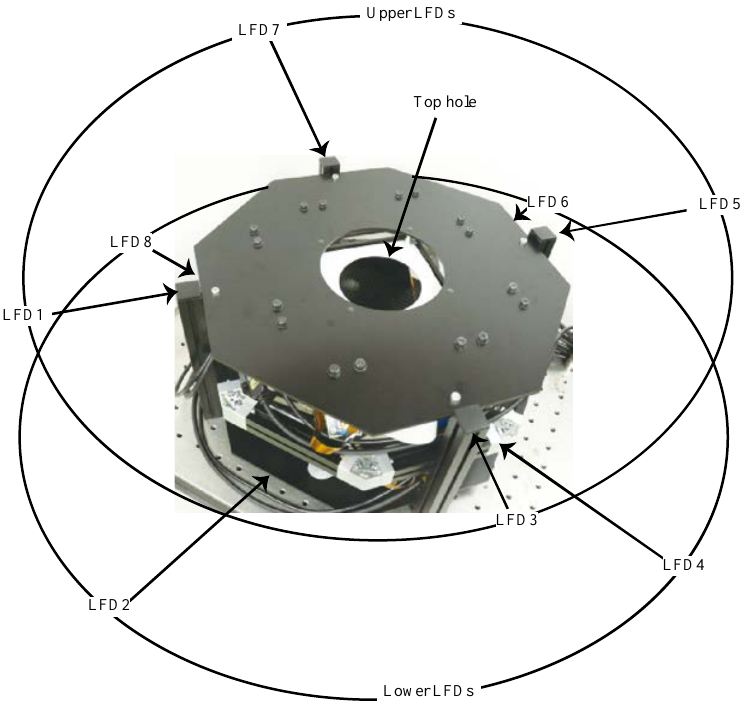
Figure 3. Constructed light field Mirage consisted of eight LFDs.